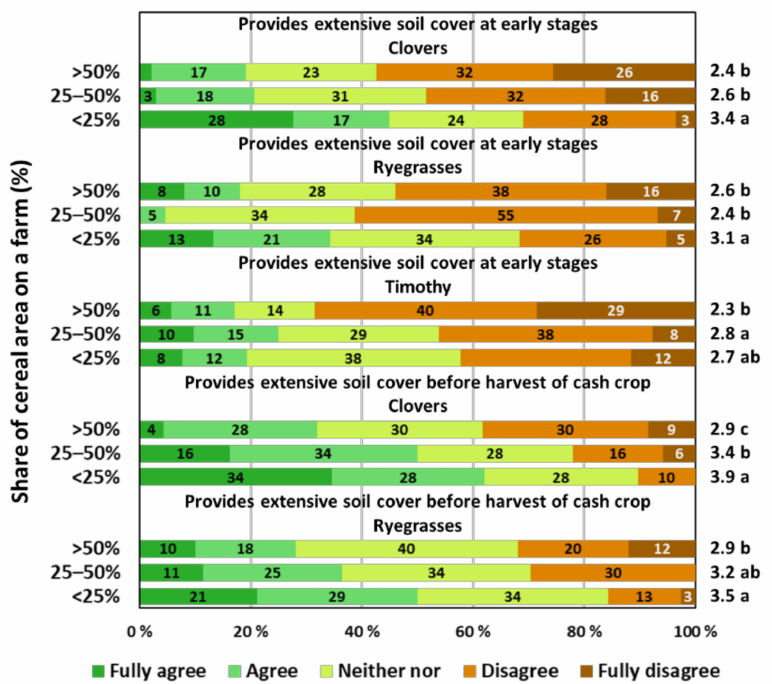
Figure 7. The distribution and mean of farmers’ experience-based answers to the statements about capacity of under-sown cover crop-groups to provide soil cover depending on the share of the cereal area on a farm. See more details in Figure